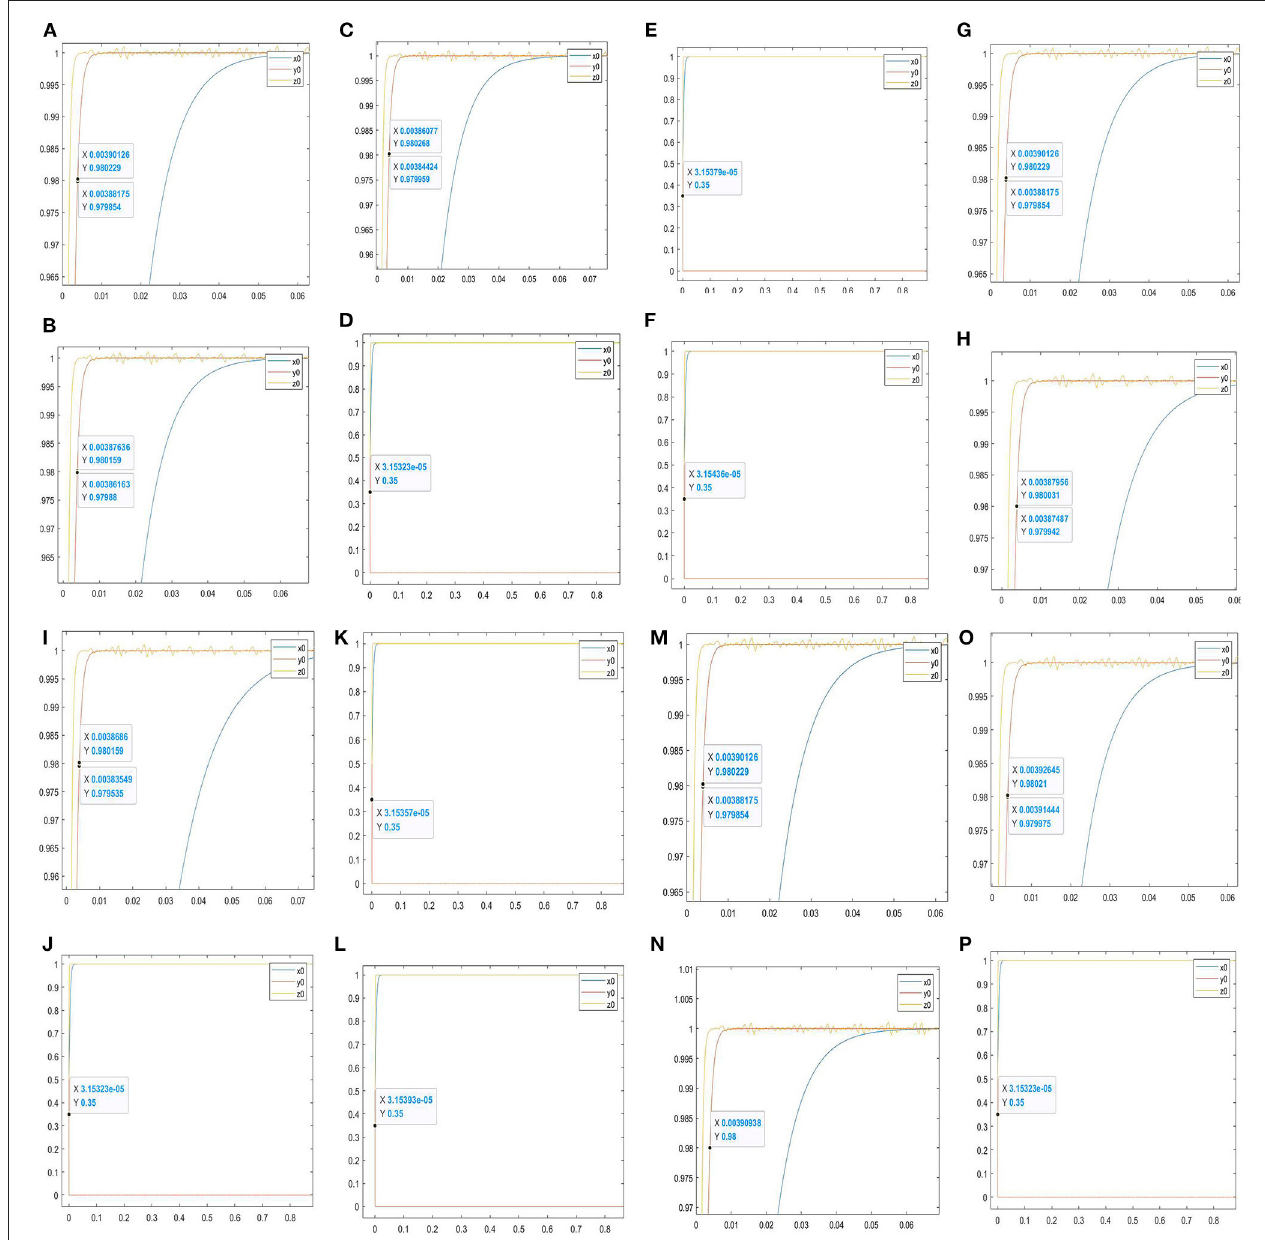
the values of other parameters remain unchanged and the evolutionary results are shown in Figure 4H ; when D 2 increases to 39, C 1( D 2 − E 1 − 6) = 195000, the values of other parameters remain unchanged and the evolutionary results are shown in Figure 4I . When y = 0.98, the corresponding abscissas of the curve y 0 are 0.00388175–0.00390126, 0.00387487–0.0387956, and 0.00383549–0.0038686, respectively. It can be seen from the figures that the increase of D 2 will accelerate the government curve to 1, and the increase of C 1( D 2 − E 1 − 6) will accelerate curves approach (1, 1, and